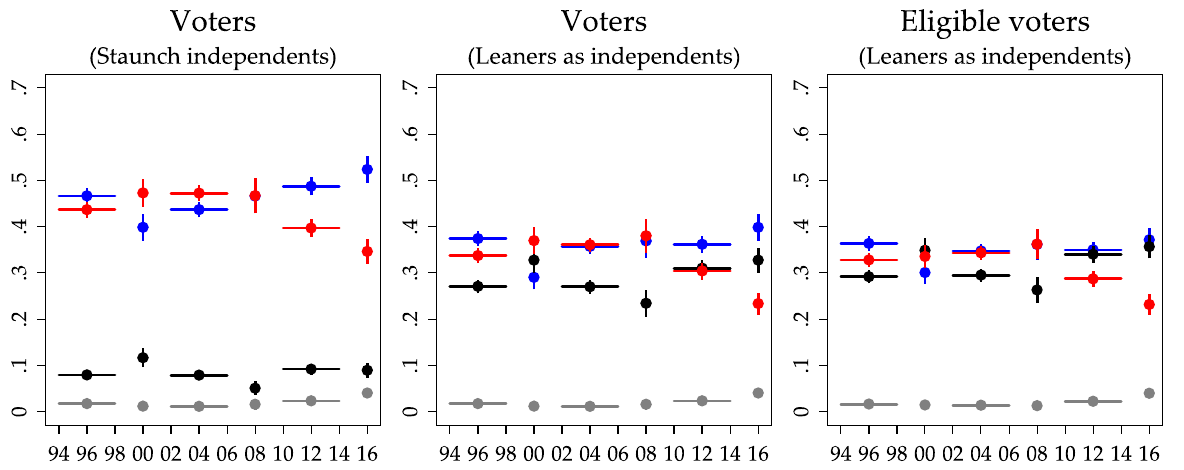
Figure 6: Class II trends in identification with the Democratic Party (blue), Republican Party (red), another party (gray), and independent